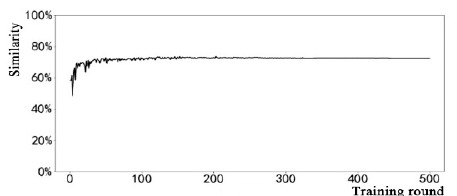
Appl. Sci. 2019 , 9 , x FOR PEER REVIEW Figure 26. Expert-driven learning with a factor of 1/3. Figure 26. Expert-driven learning with a factor of 1 / 3. Figure 26. Expert-driven learning with a factor of 1/3. Figure 26. Expert-driven learning with a factor of 1/3. Figure 26. Expert-driven learning with a factor of 1/3.